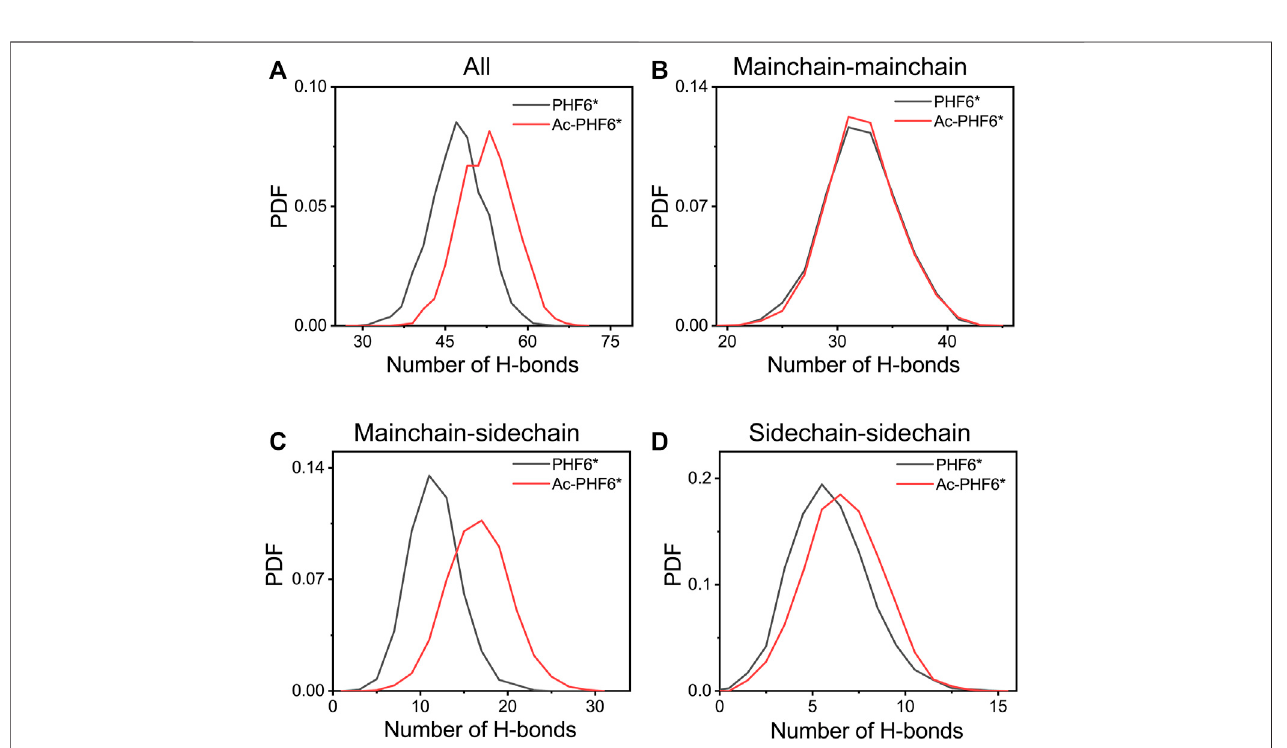
FIGURE5| Probabilitydistributionfunctionoftotal (A) ,mainchain-mainchain (B) ,mainchain-sidechain (C) andsidechain-sidechain (D) inter-chainH-bondnumber in the PHF6* and Ac-PHF6* systems.